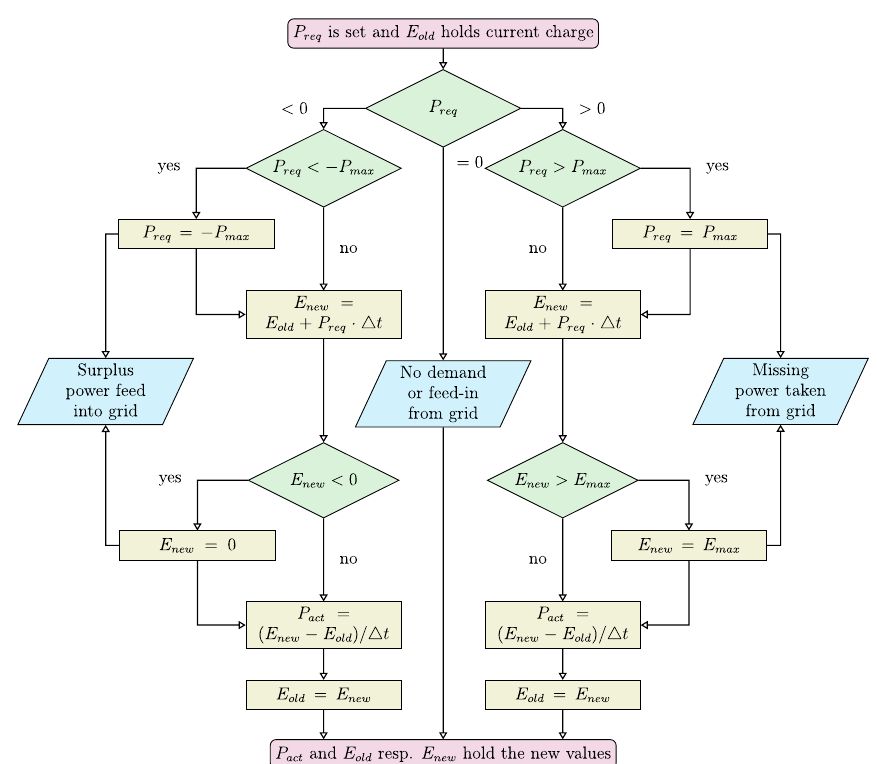
Fig. 5 Internal logic of the battery for charging or discharging. △ t is the step size between two time steps in hours. E old is the current battery charge at the end of the last step, E new the battery charge at the end of the step, P req is the charge request and P Bat act , c the actual power that can be delivered from or fed into the battery. Above, P act is also noted as P Bat act , c ( t ) , but for the sake of clarity indices are not shown in this